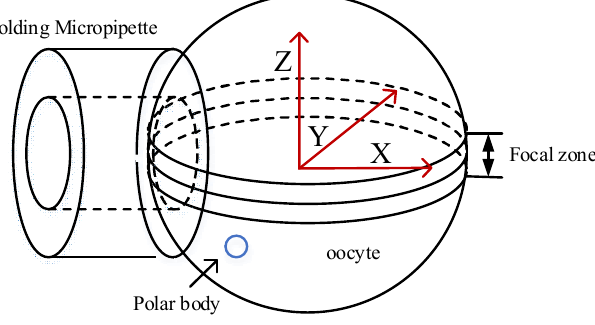
Figure 1. Three-dimensional model of oocyte rotation.